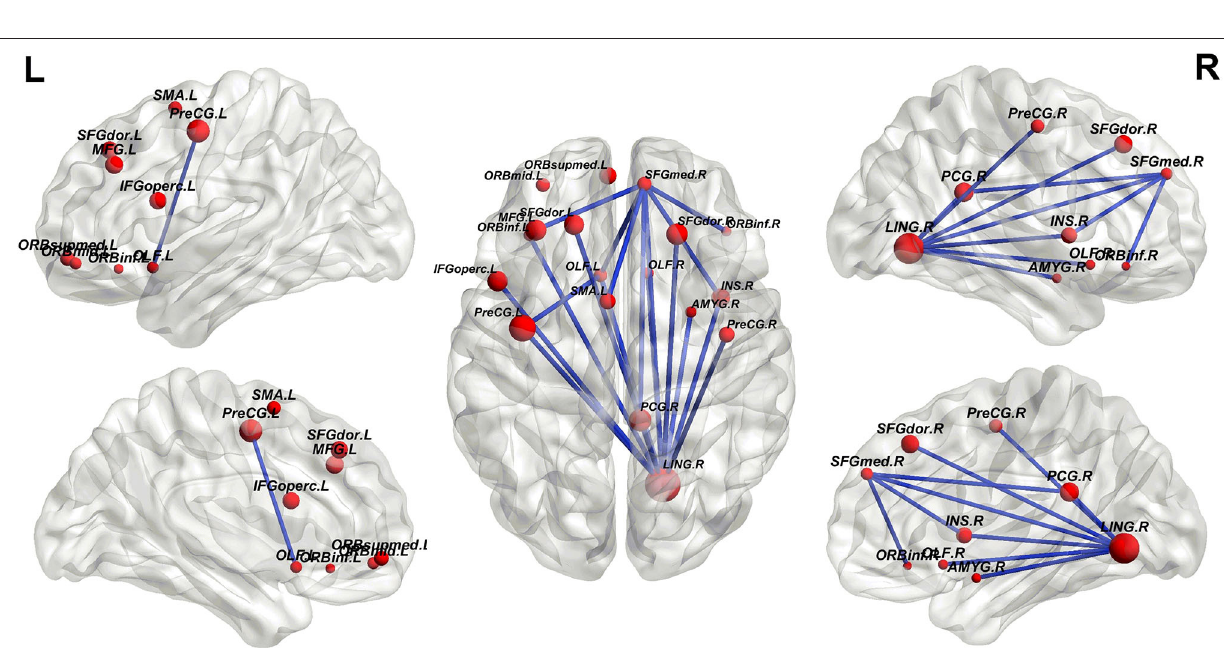
Frontiers in Neuroscience | www.frontiersin.org 8 May 2022 | Volume 16 | Article